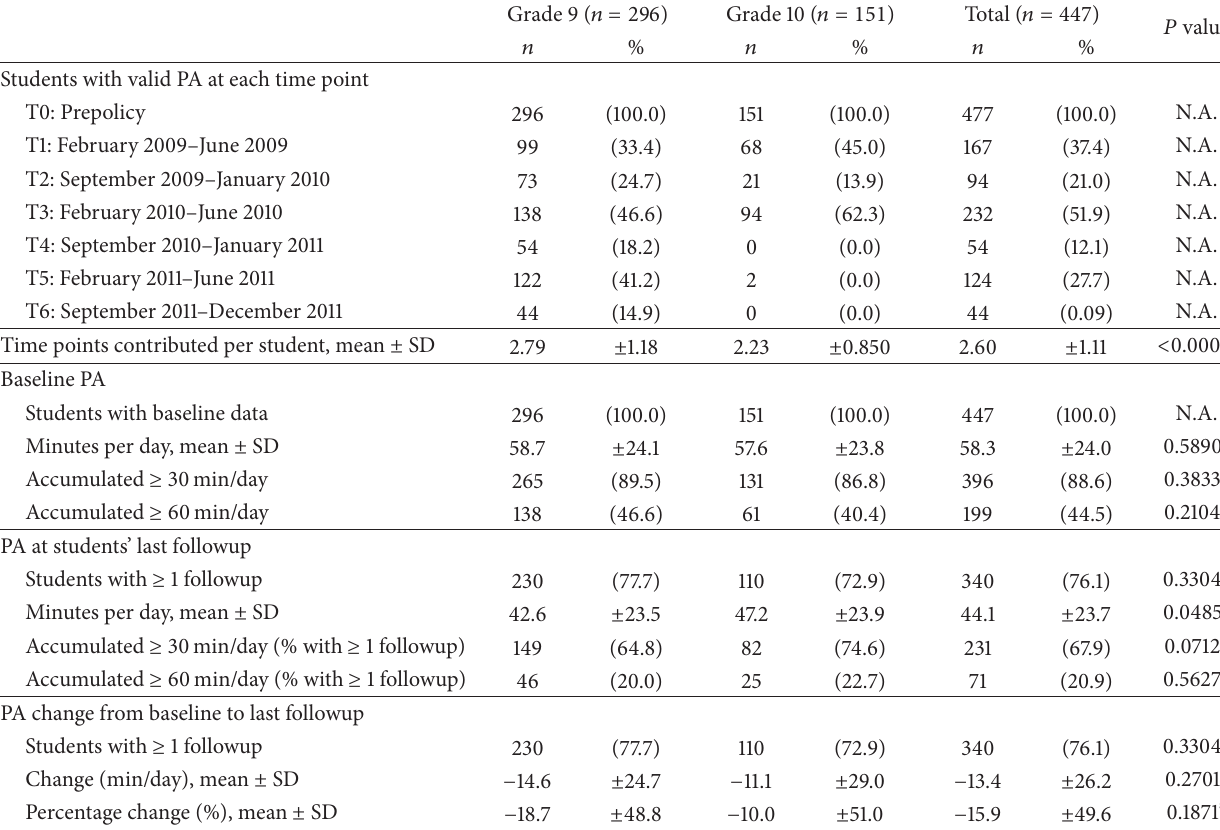
Table 2: Objectively measured physical activity at baseline and follow-up periods across grade cohorts and total study